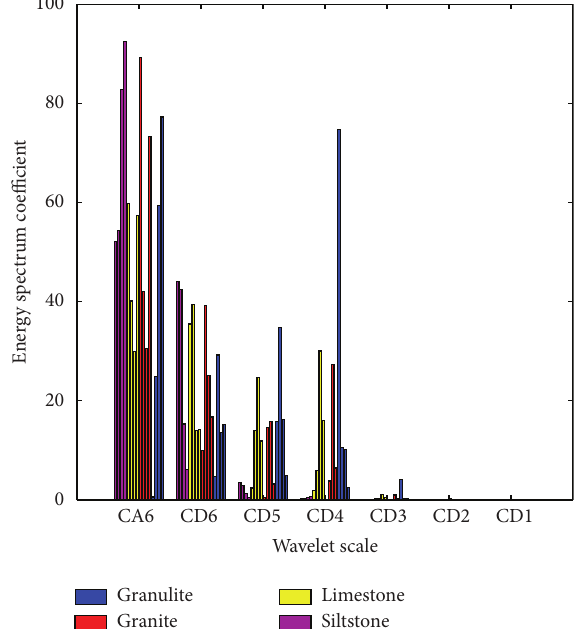
Figure 10: The distribution of the energy spectrum after the wavelet transform.